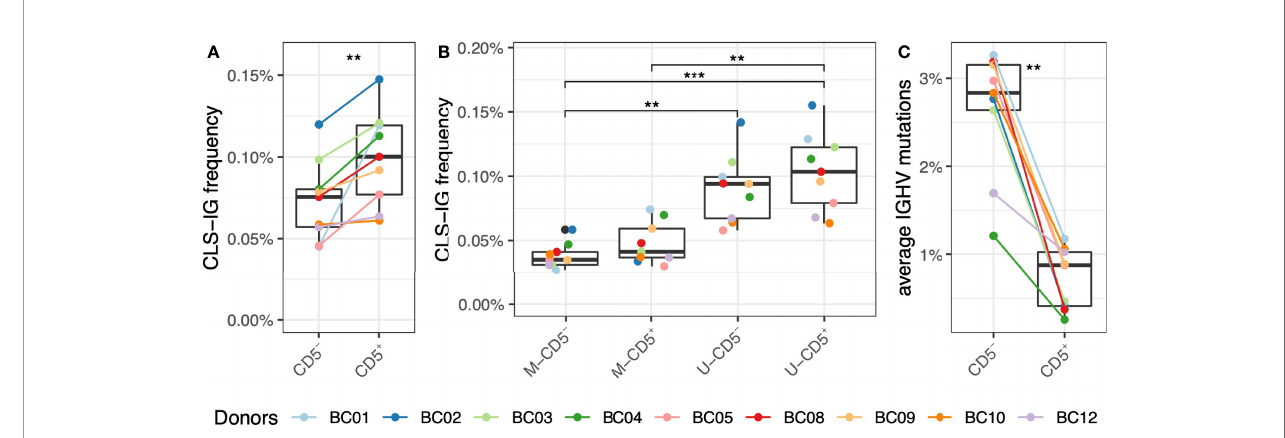
FIGURE 2 | Frequency of CLS-IG in CD5 + and CD5 - B cells. (A) CLS-IG frequency in CD5 + and CD5 - B cells analyzed in bulk. (B) Frequency of CLS-IG in the M and U IGHV rearrangements of CD5 + and CD5 - B cells analyzed separately. (C) IGHV genes mutation distribution in CD5 + and CD5 - B cells. Paired Wilcoxon test was performed, only signi fi cant statistics are shown (**p ≤ 0.01, ***p ≤